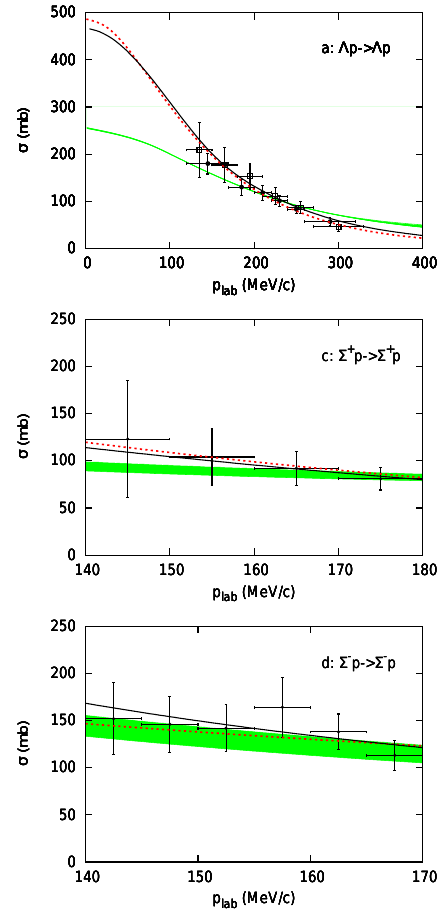
Fig. 1. YN integrated cross sections as a function of p lab . The band are results based on chiral EFT to LO for cuto ff s Λ = 550 , ..., 700 MeV, while the solid and dashed curves are those of the J¨ulich ’04 [21] and Nijmegen NSC97f [22] meson-exchange models,